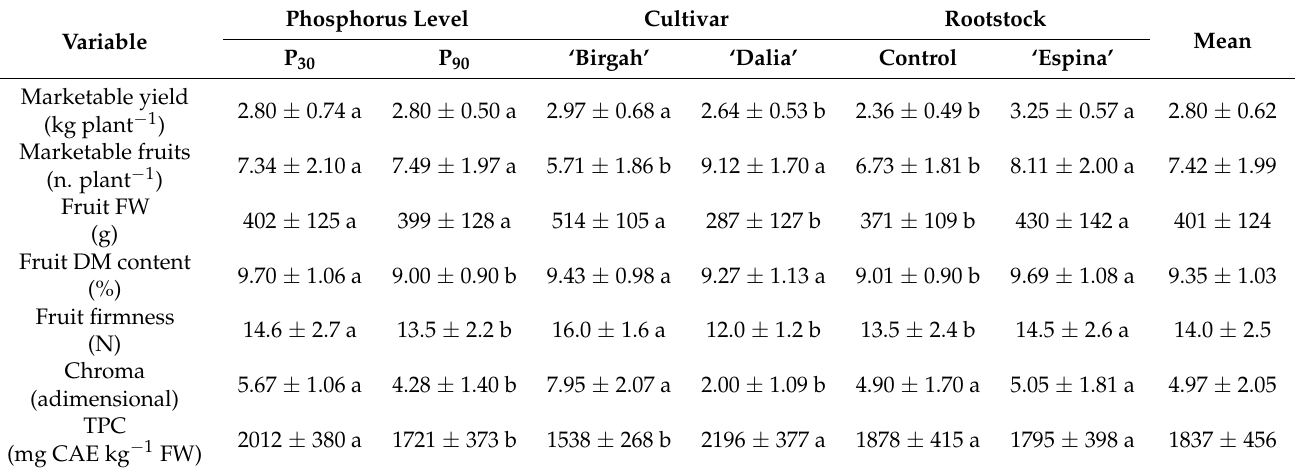
Table 2. Yield performances, carpometric traits and TPC of eggplants as affected by the main factors (mean ± standard deviation). Different letters among factors’ means indicate significance at Tukey’s HSD test ( p ≤